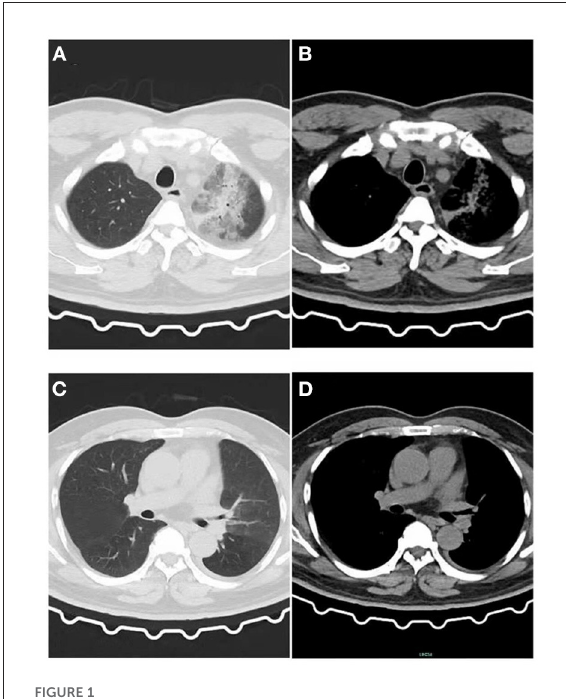
FIGURE2 After he was given Latamoxef Sodium as empirical treatment for 6 days. (A) Lung window: The patchy high-density shadow in the upper lobe of the left lung is obviously absorbed. (B) Mediastinal window: Exudative lesions in the upper lobe of the left lung were obviously absorbed. (C) Lung window: New patchy high-density shadow in the lower lobe of the left lung with i blurred edges, pleural effusion was absorbed more than before. (D) Mediastinal window: Newly emerging exudative lesions in the left lower